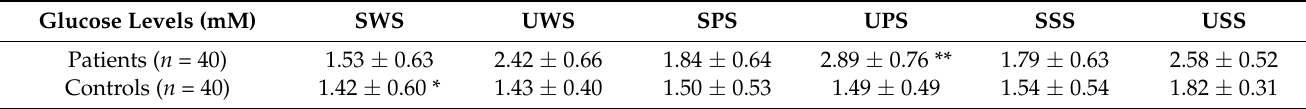
Table 2. The average levels of saliva glucose for each group (DM patient/control and stimu-